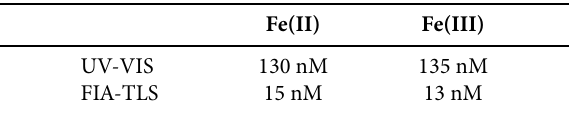
Table 2. Comparison of LODs for determination of Fe(II) and Fe(I- II) by FIA-TLS and UV-VIS spectrophotometry Fe(II)